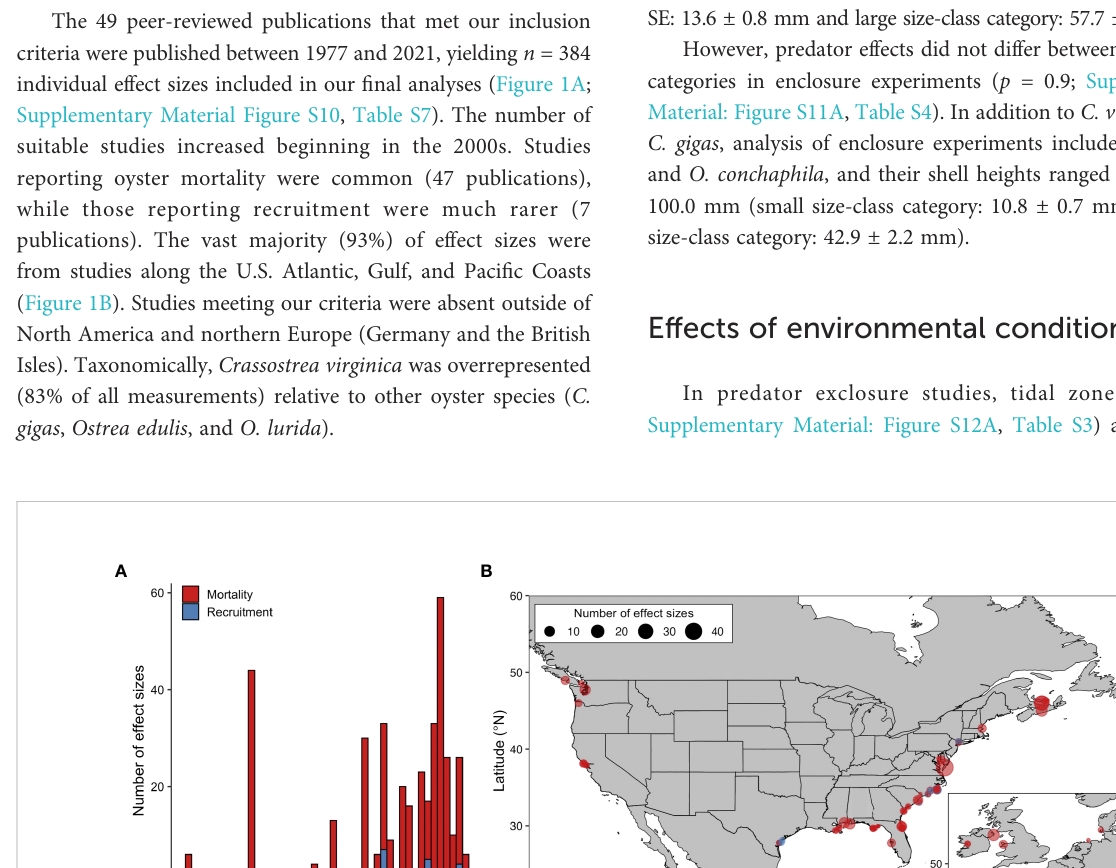
FIGURE 1 The annual number of individual predator exclusion experiments (or effect sizes) included in the meta-analysis (A) . Global distribution of experiments (B) that measured oyster mortality ( n = 362) and recruitment ( n = 22). Points indicate the location of suitable studies; larger points indicate more effect sizes. Panel A legend also corresponds to panel